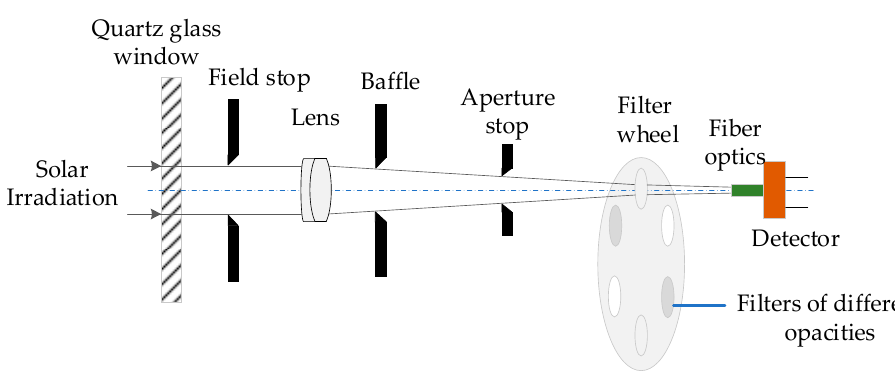
Figure 3. Spectrum acquisition light-path.